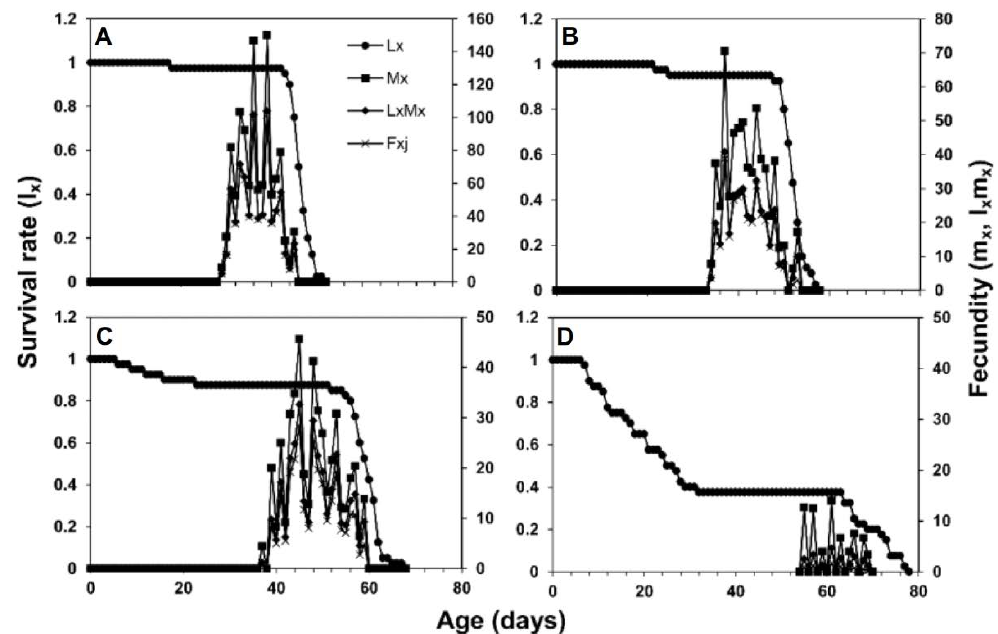
Figure 3. Age-specific survival rate ( l x ), age stage-specific fecundity ( f xj ), age-specific fecundity ( m x ), and age-specific maternity ( l x m x ) of S. frugiperda fed on four host plants, maize ( A ), sorghum ( B ), wheat ( C ) and rice ( D ).